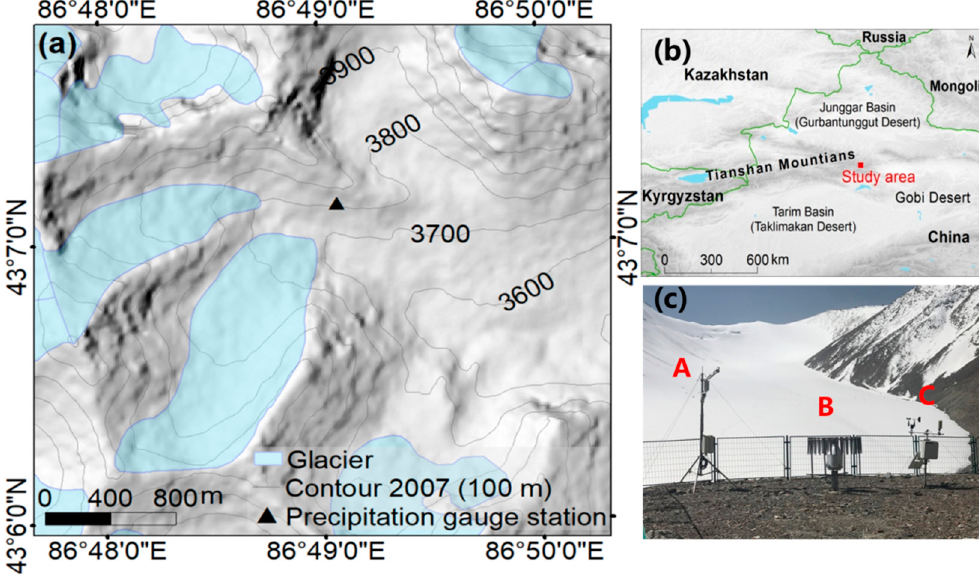
Figure 1. Experiment site description: ( a ) sketch map of the study catchment; ( b ) location of the study area; ( c ) experiment site with PWS100 (A), Geonor T-200B (B) and Automatic Weather Station (AWS) (C).